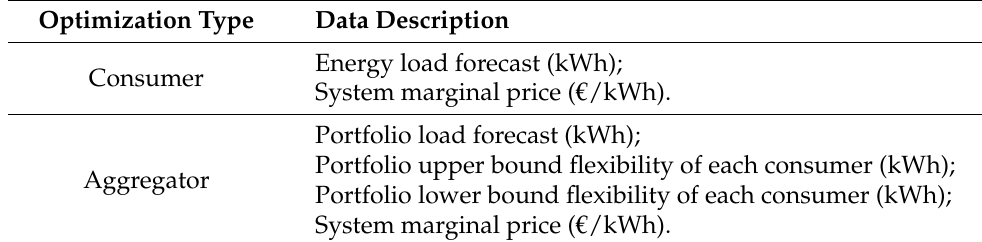
Table 1. Dataset description for the two types of